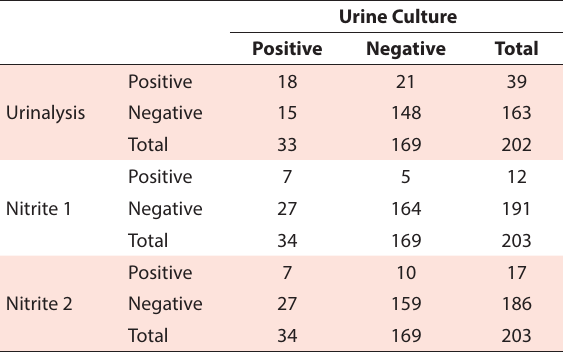
Table 4. Sensitivity and specificity of the diagnostic method of urinalysis